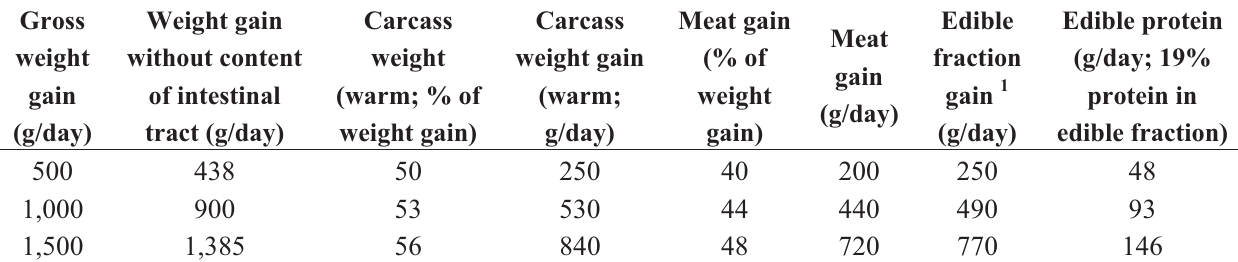
Table 4. Model calculation to show various endpoints for growing/fattening bulls (150–550 kg body weight; calculation based on data collected by [84]).